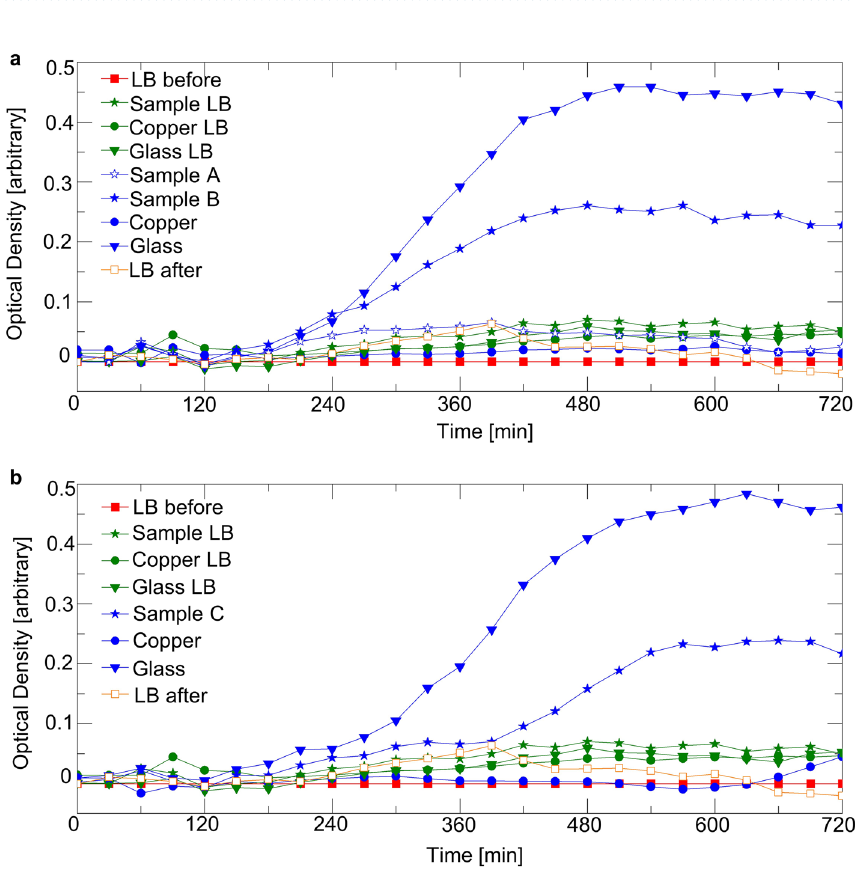
Figure 7. Spectrophotometer results for recording 12 h of E. coli growth on the cicada wing replica with dilution ratios of ( a ) 1:2 and ( b )